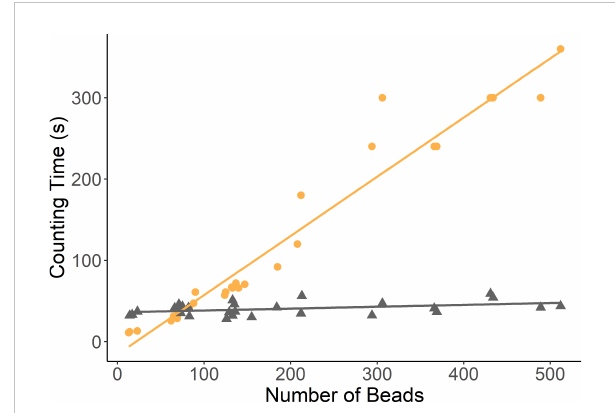
FIGURE 3 Scatter plot of the time taken to count the beads from X-ray images feed samples of increasing masses. (Manual counting times denoted in orange by full circles. Image analysis algorithm counting times denoted by triangles in grey).